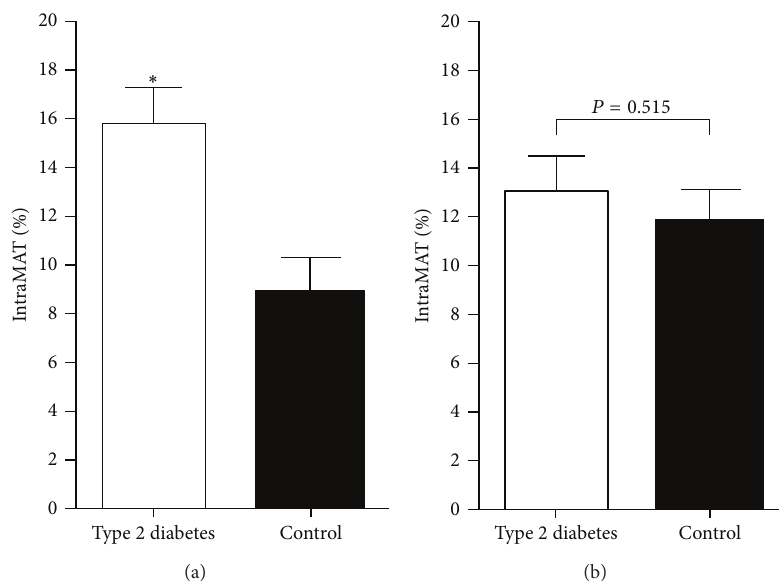
Figure 2: Unadjusted (a) and adjusted (b) comparison of percent IntraMAT in women with and without type 2 diabetes. IntraMAT: intramuscular adipose tissue. ∗ 𝑃 < 0.05 considered significant. Percent IntraMAT = [IntraMAT (mm 2 ) ÷ total muscle area (mm 2 )] × 100%. Covariates: age, ethnicity, BMI, waist :hip ratio, and weekly energy